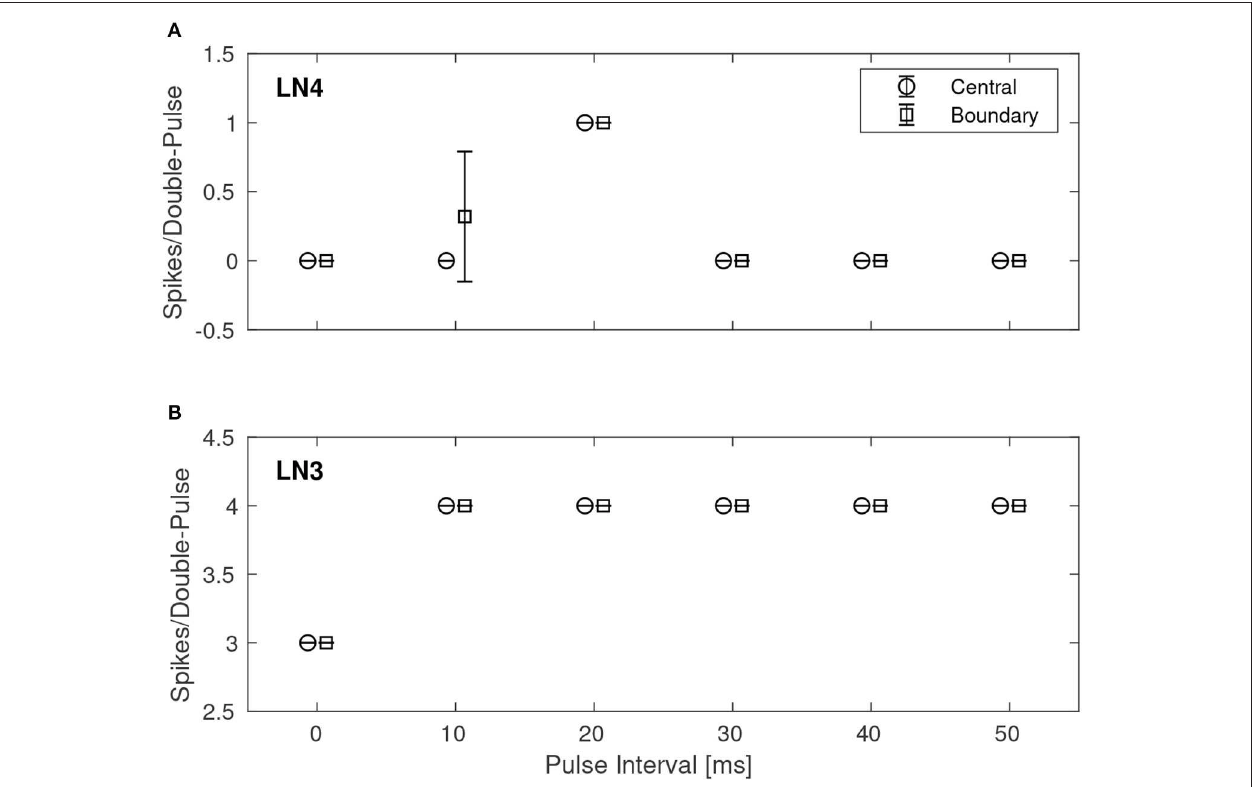
FIGURE 7 | Average number of spikes from LN3 and LN4 per double-pulse stimulus for varying IPIs and two different bias configurations: one central to, and one on the boundary of, the region illustrated in Figure 6 . For each IPI, the data-points are graphically separated by 4/3 ms to improve clarity of the visualization. Error bars denote ± 1 standard deviation. (A) Feature detecting neuron, LN4. (B) Coincidence detecting neuron, LN3.